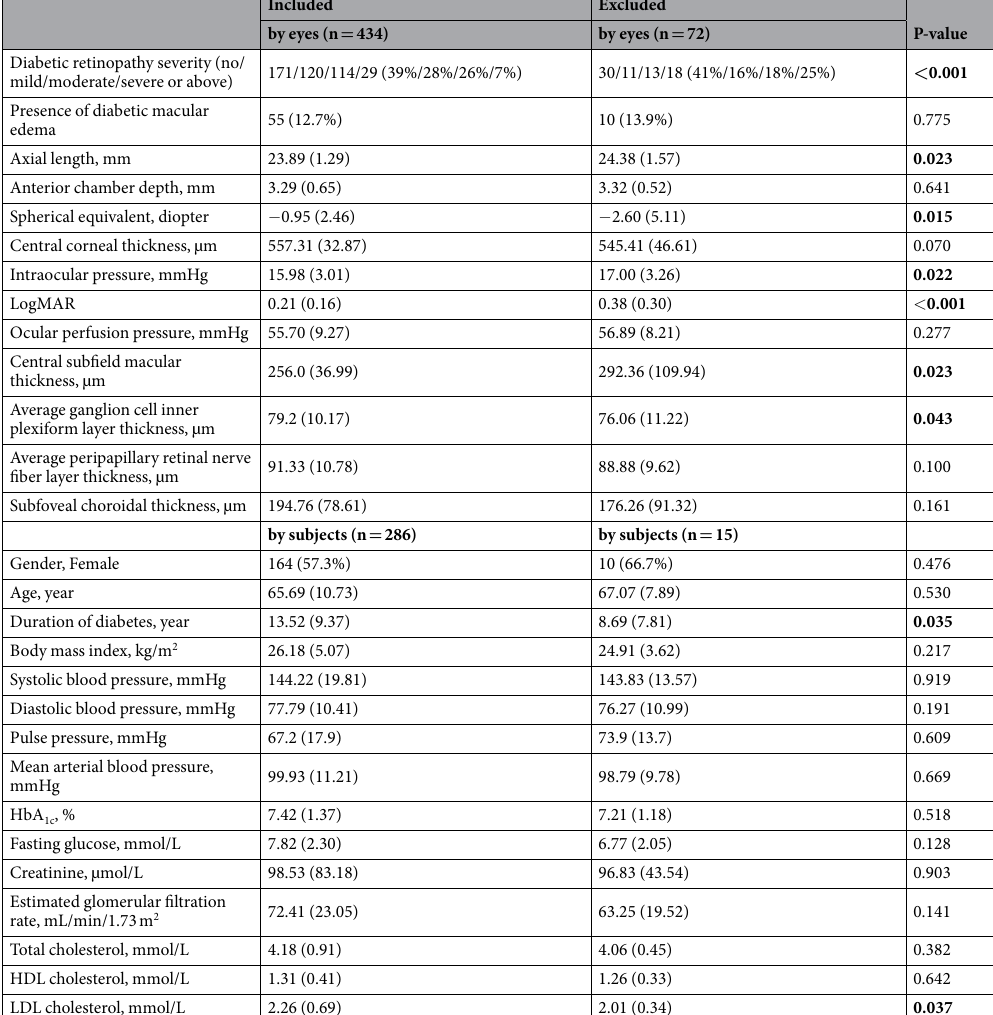
Table 1. Clinical Characteristics of included diabetic participants in the analysis compared with excluded participants. Data are N (%) or mean (standard deviation). HDL = High-density lipoprotein; LDL = Low- density lipoprotein; LogMAR: logarithm of the minimum angle of